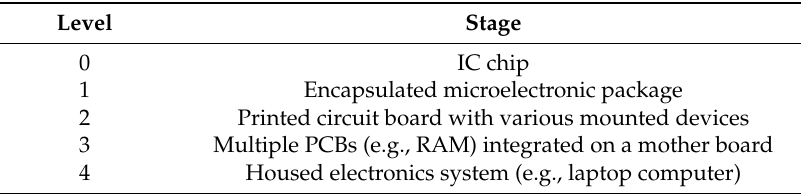
Table 1. Definition of different levels of packages according to Ref. [1]. (IC: integrated circuit, RAM: random-access